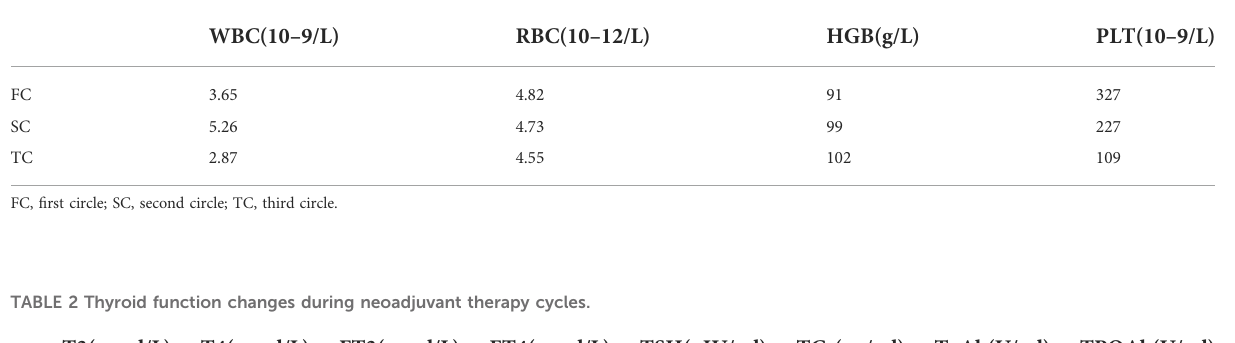
TABLE 1 Changes of main indexes of blood routine during neoadjuvant therapy cycle.